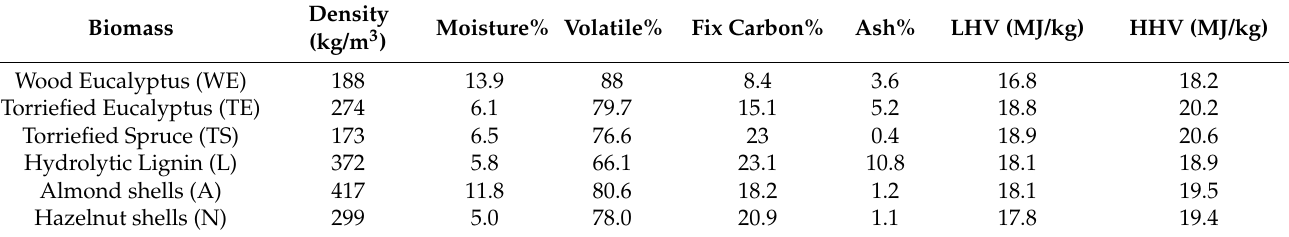
Table 3. Physical characteristics and proximate analysis [19,21,22].